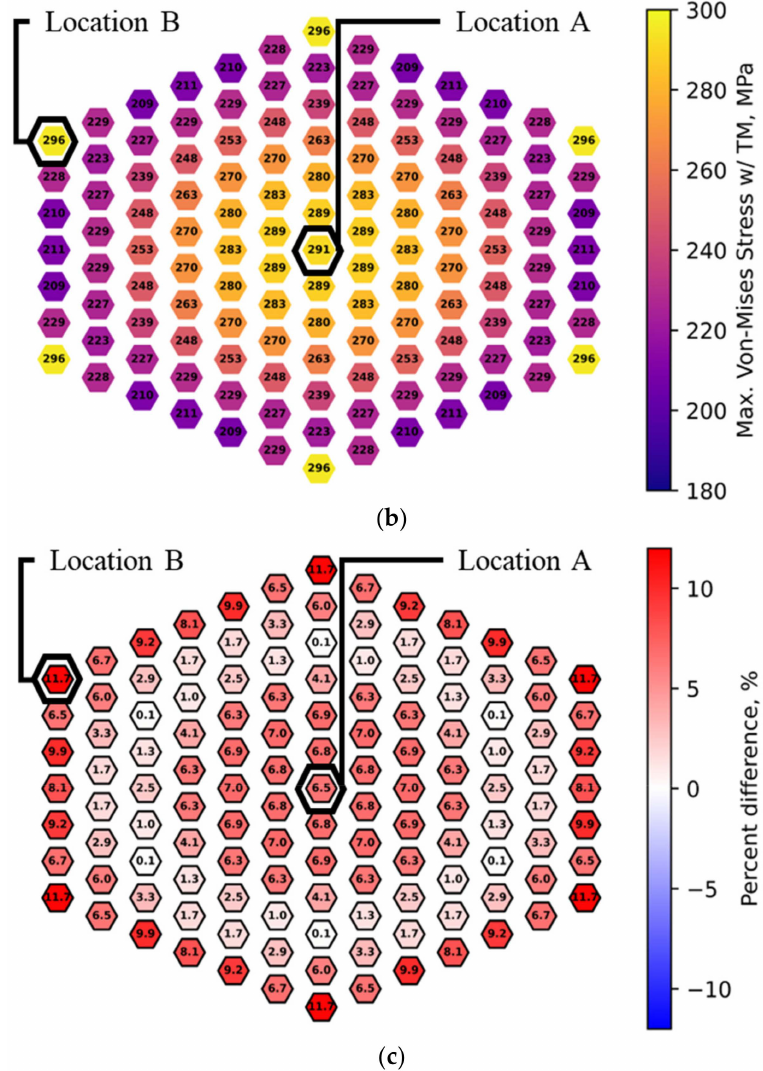
Figure 16. Comparison of maximum von Mises stress ( a ) w/o T/M feedback; ( b ) w/ T/M feedback; ( c ) percent